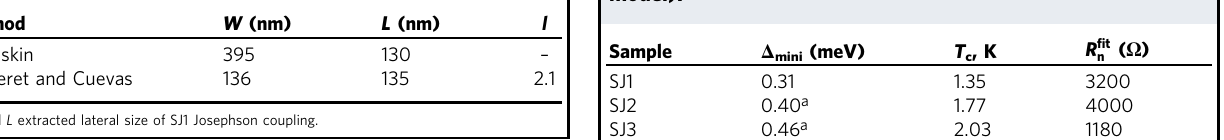
Table 6 Critical current versus temperature (diffusive model).